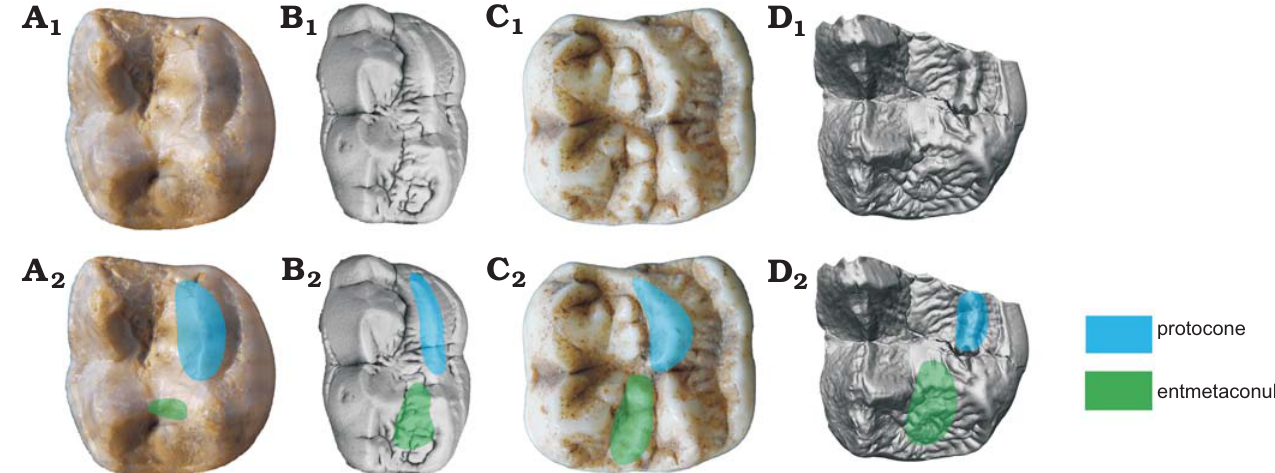
Fig. 5. Occlusal views of M1 homologous structures in cave bear (A, B) and giant panda (C, D) lineages. A . Ursavus tedfordi Qiu, Deng, and Wang, 2014 (HMV1453) from Huaigou, Gansu Province, Late Miocene. B . Ursus deningeri Von Reichenau, 1904 (NMM1953/119, photo Jan Wagner) from Mosbach 2, Germany, early Middle Pleistocene. C . Ailuropoda melanoleuca (David, 1869) (IVPP V87025.109) from cave deposit of Guangxi Province, Late Pleistocene. D . Ailurarctos lufengensis Qiu and Qi, 1989 (IVPP V6892) from Lufeng, Yunnan Province, Latest Miocene. A 1 –D 1 , photographs; A 2 –D 2 , photographs with homologous structures indicated. Not to